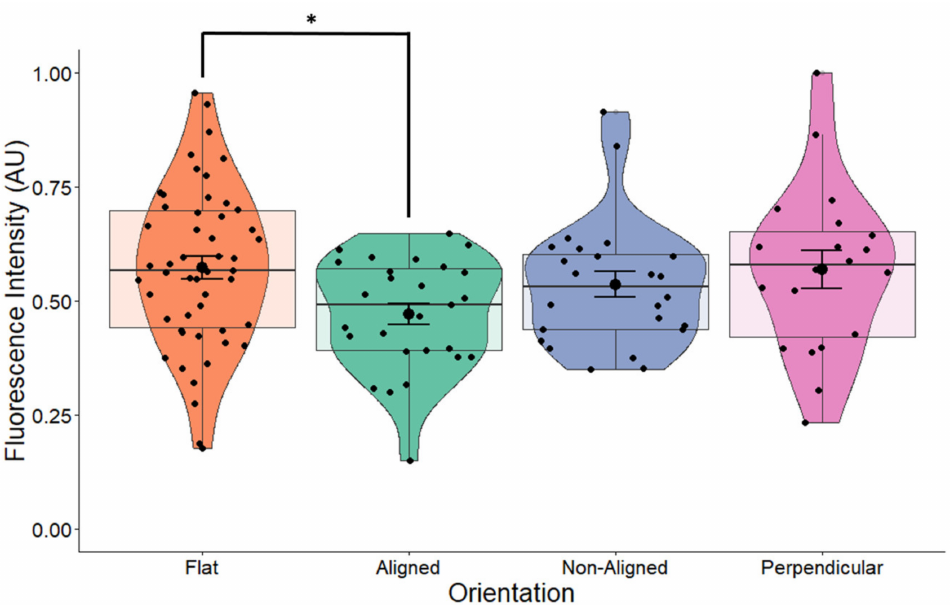
Figure 5. BDNF expression in non-stimulated SH-SY5Y cells grown on scaffolds with different orientations. BDNF expression was measured in fluorescently labeled cells using confocal microscopy. BDNF expression levels were significantly decreased ( p = 0.042) in cells grown on aligned scaffolds. * p < 0.05. Flat n = 49, aligned n = 27, non-aligned n = 24, perpendicular n =